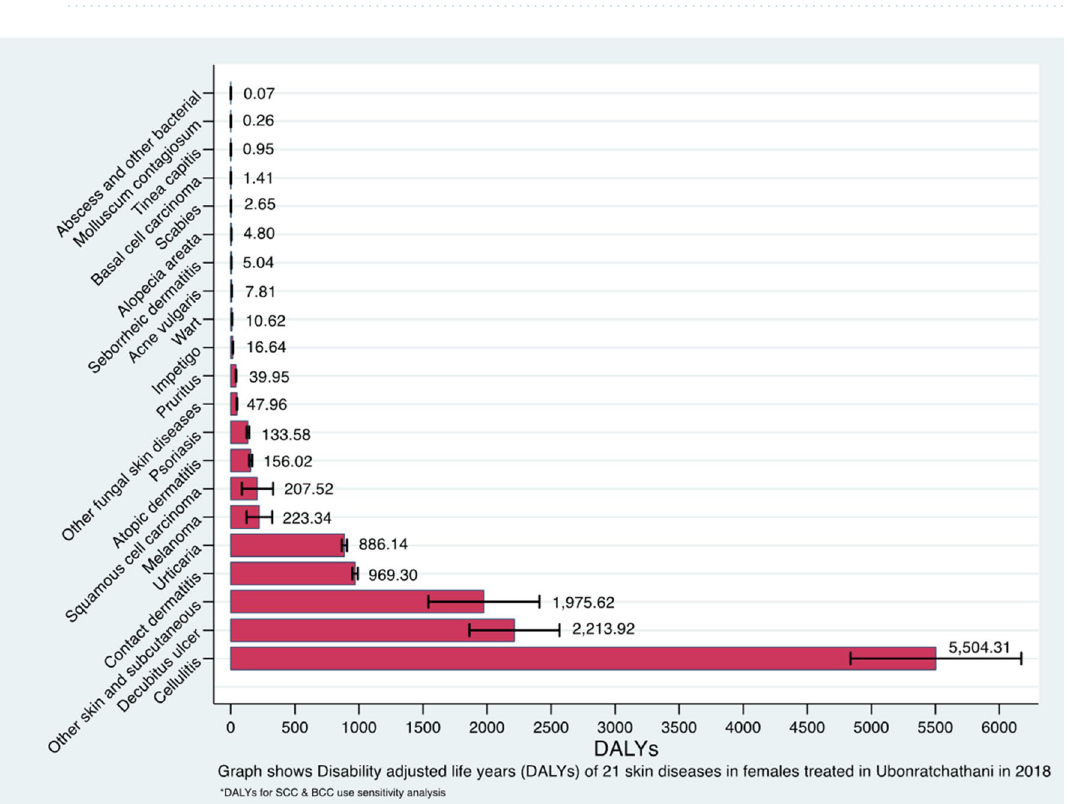
Figure 2. DALYs due to different skin diseases in males (in ascending order).